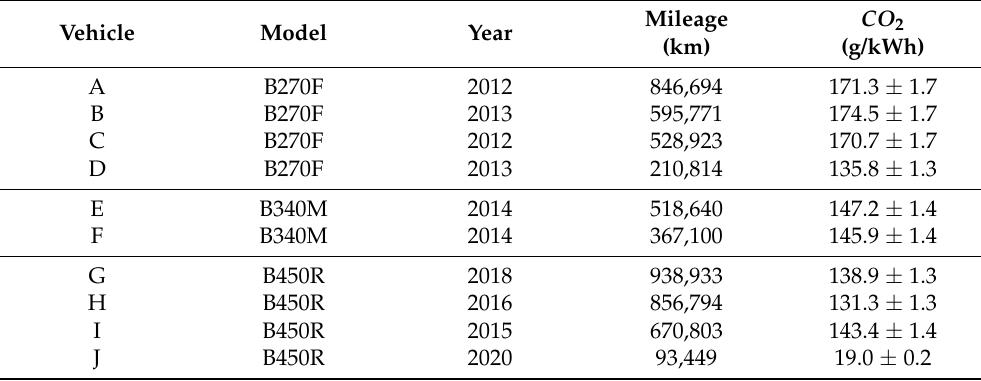
Table 6. Influence of mileage traveled on the evolution of ( CO 2 ) emissions.